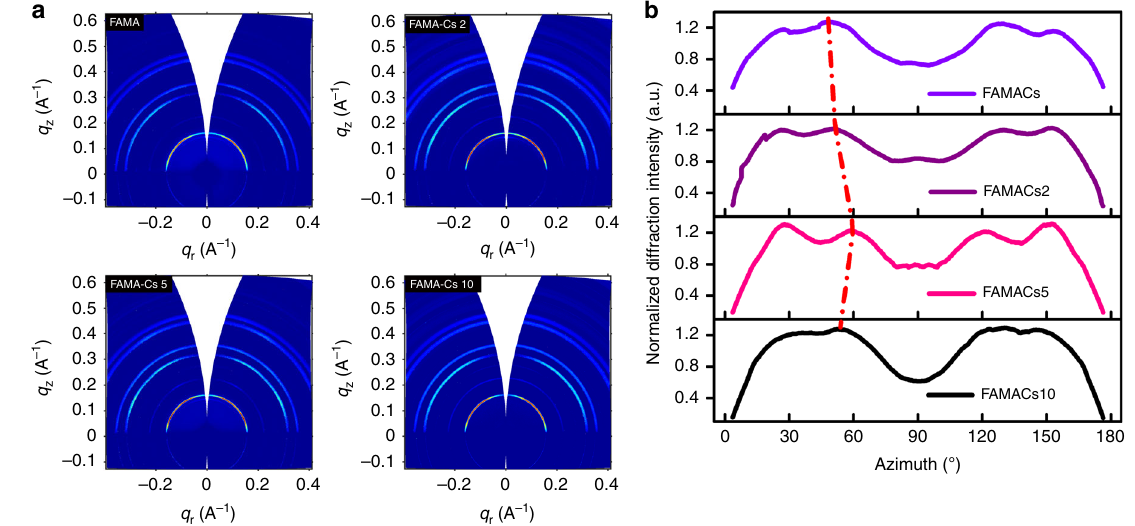
Fig. 3 GIWAXS analysis for cesium-doped samples. a GIWAXS patterns for perovskite fi lms with different cesium concentration labeled as FAMA-Cs 0, FAMA-Cs 2, FAMA-Cs 5, and FAMA-Cs 10. b Integrated intensity plots azimuthally along the ring at q r approximate to 0.16 Å − 1 , assigned to the (001) plane of corresponding perovskite fi lms corresponding to those in